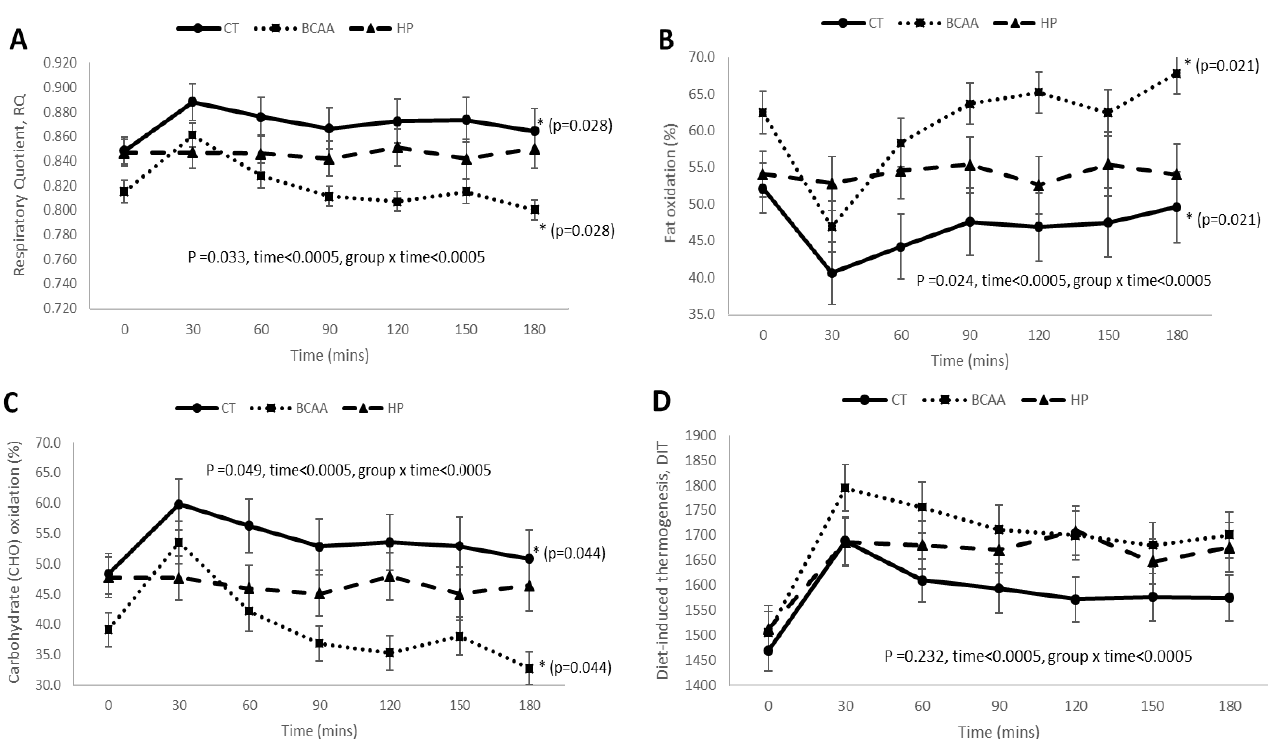
Figure 4. Postprandial RQ, fat oxidation, carbohydrate oxidation, and DIT responses among the three diet groups after 16 weeks of weight loss intervention. ( A ) Postprandial RQ responses among the 3 diet groups; ( B ) postprandial fat oxidation responses among the 3 diet groups; ( C ) postprandial carbohydrate oxidation responses among the 3 diet groups; ( D ) postprandial DIT responses among the 3 diet groups. Data were presented as mean ± standard error and analyzed by repeated measures ANOVA (between subject groups). Abbreviations: standard-protein with BCAA, BCAA; standard-protein with placebo, CT; high-protein with placebo, HP. * denotes significant difference of p < 0.05 between